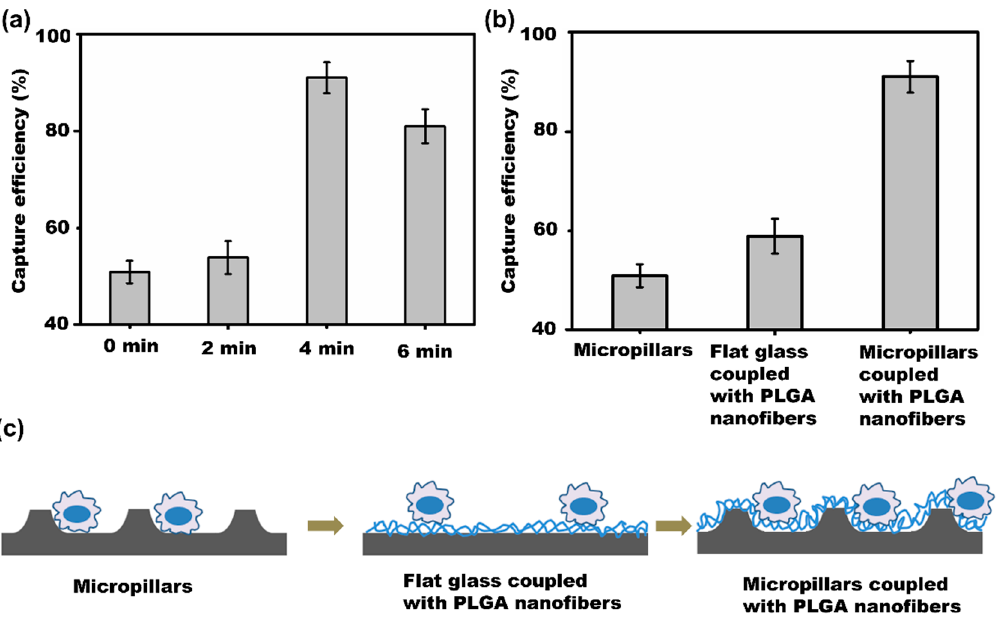
Figure 6. Effect of PLGA nanofibers electrospinning time ( a ) and different substrates ( b ) on the can- cer cell capture efficiency. ( c ) Scheme of the contact site of cancer cells on the different substrates.